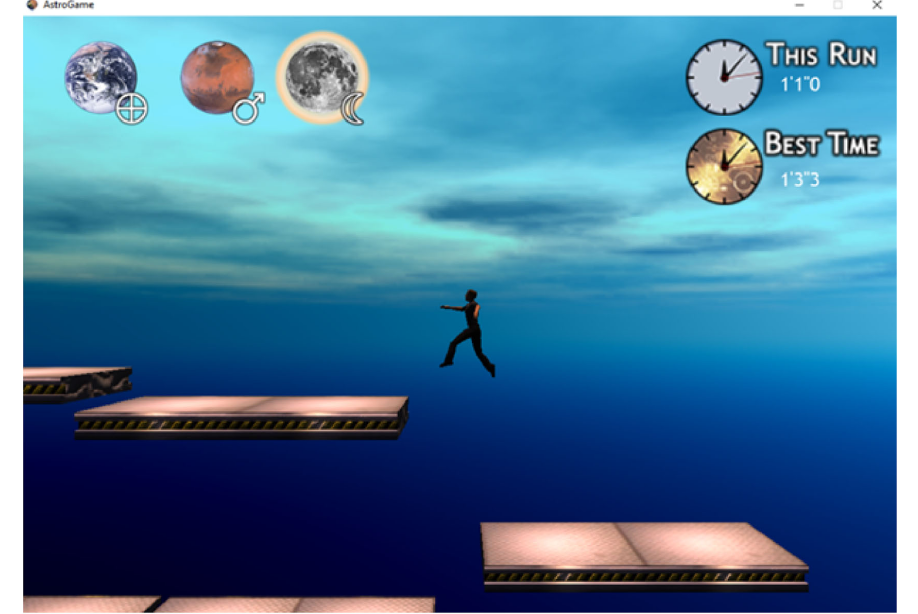
FIG. 2. Screenshot from the Gravity Platformer minigame showing the player avatar jumping between platforms in Moon